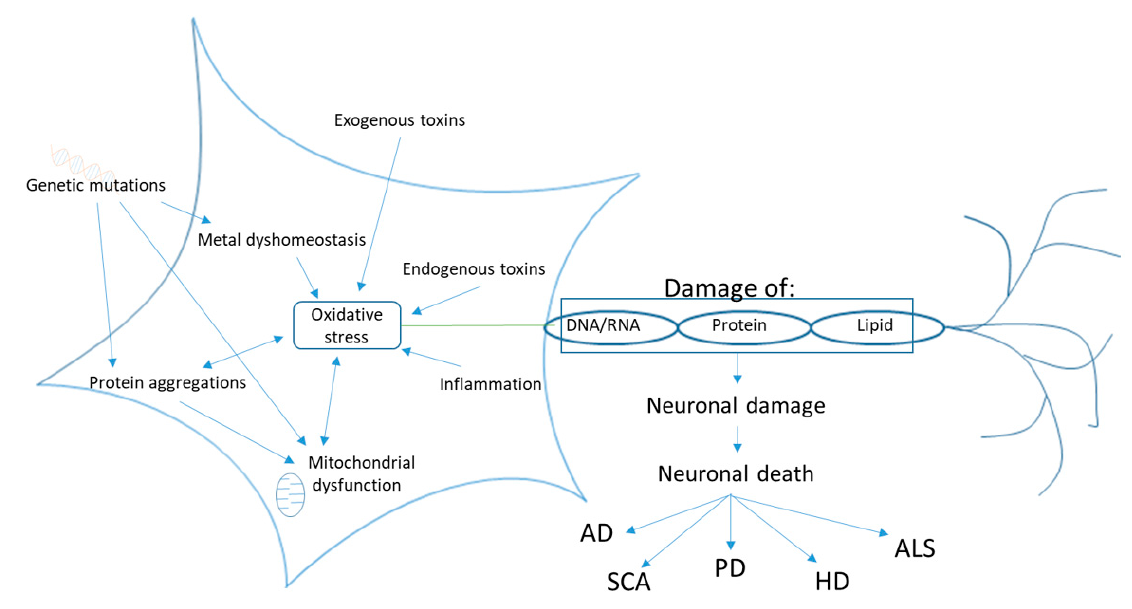
Figure 3 . Causes of oxidative stress in neurodegeneration, AD—Alzheimer’s disease, SCA—Spinocerebellar Ataxia, PD—Parkinsons disease, HD—Huntington’s disease, ALS—Amyotrophic lateral sclerosis, adapted from [32,33].